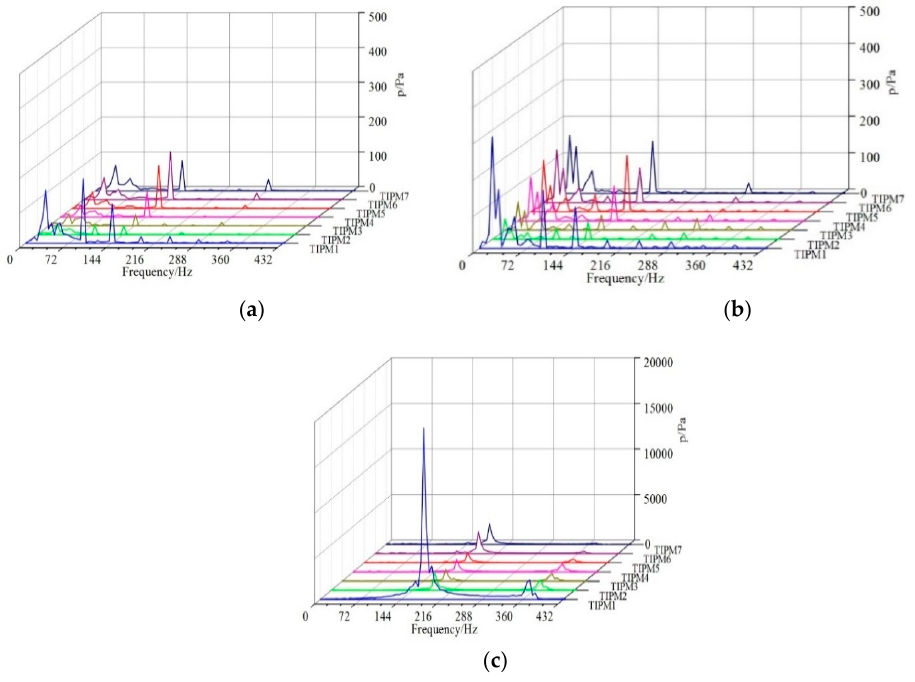
Figure 28. Spectrum of the pressure fluctuations on blade tip from leading edge to trailing edge: ( a ) δ = 0.2 mm; ( b ) δ = 0.65 mm; ( c ) δ = 1.0 mm [2].